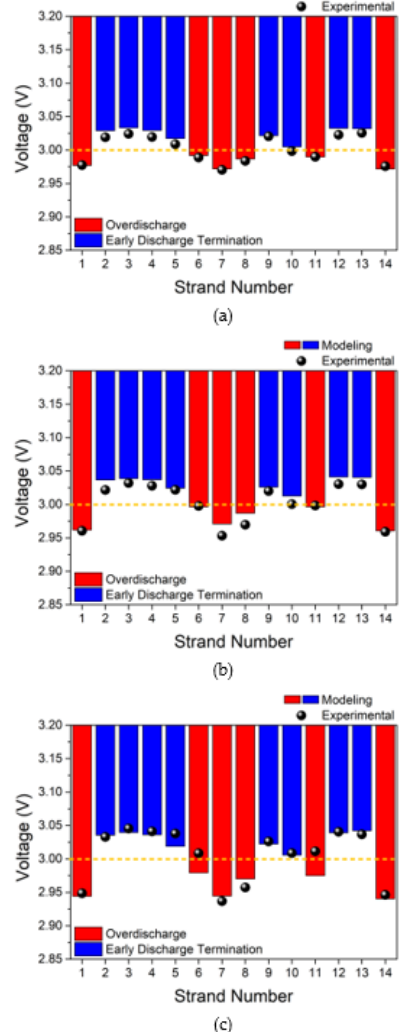
Figure 10. Comparison of experimental results with modeling results of the voltage of LIB strands at the end of discharge ( a ) 0.2 C, ( b ) 0.5 C, and ( c ) 1 C.